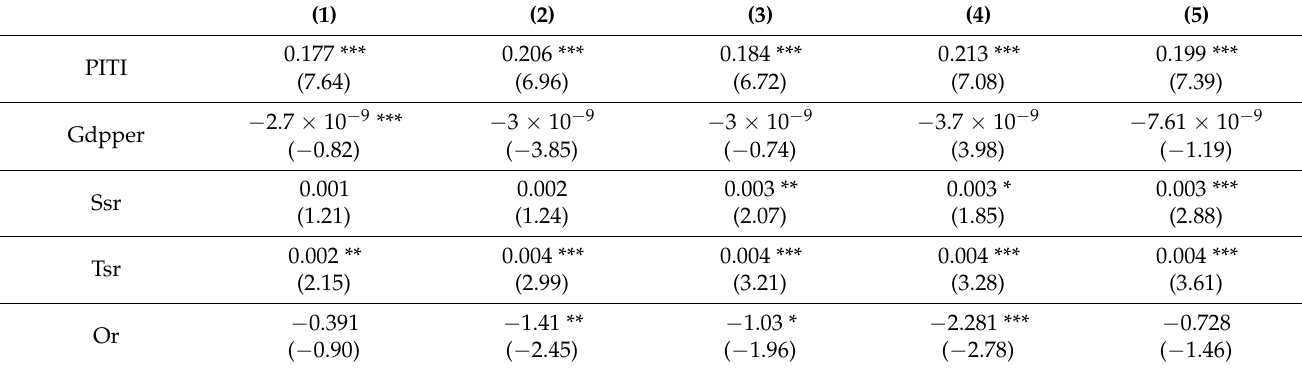
Table 5. Robustness test